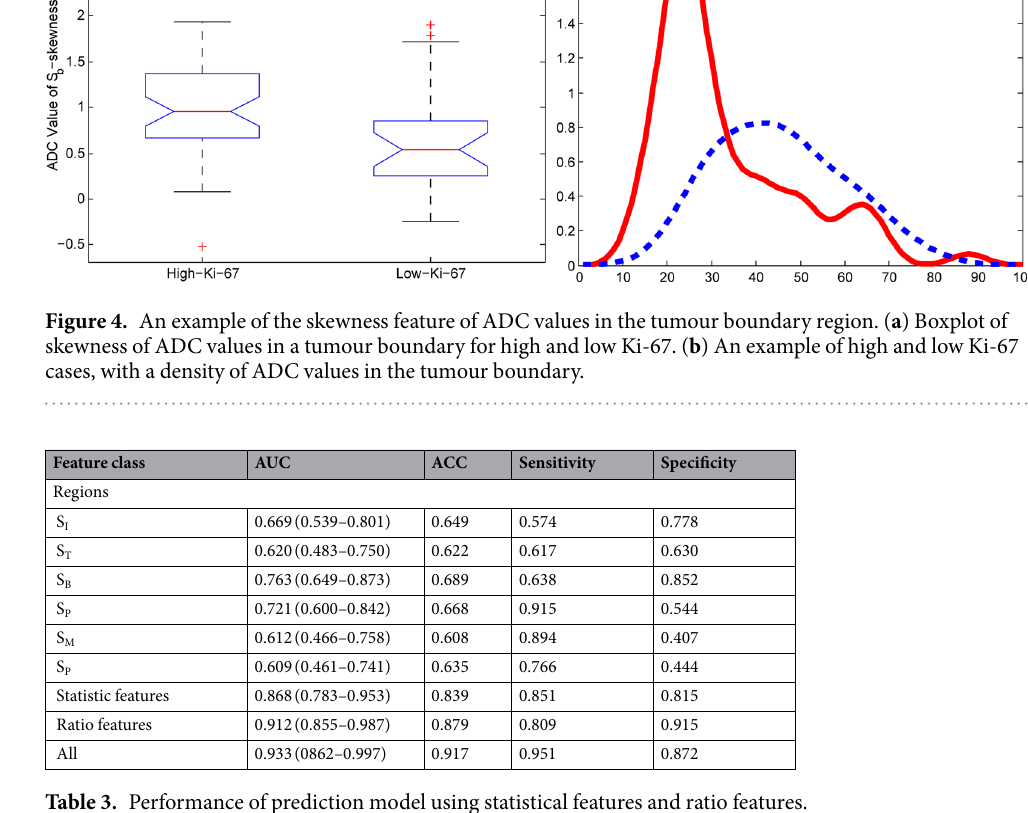
Table 3. Performance of prediction model using statistical features and ratio